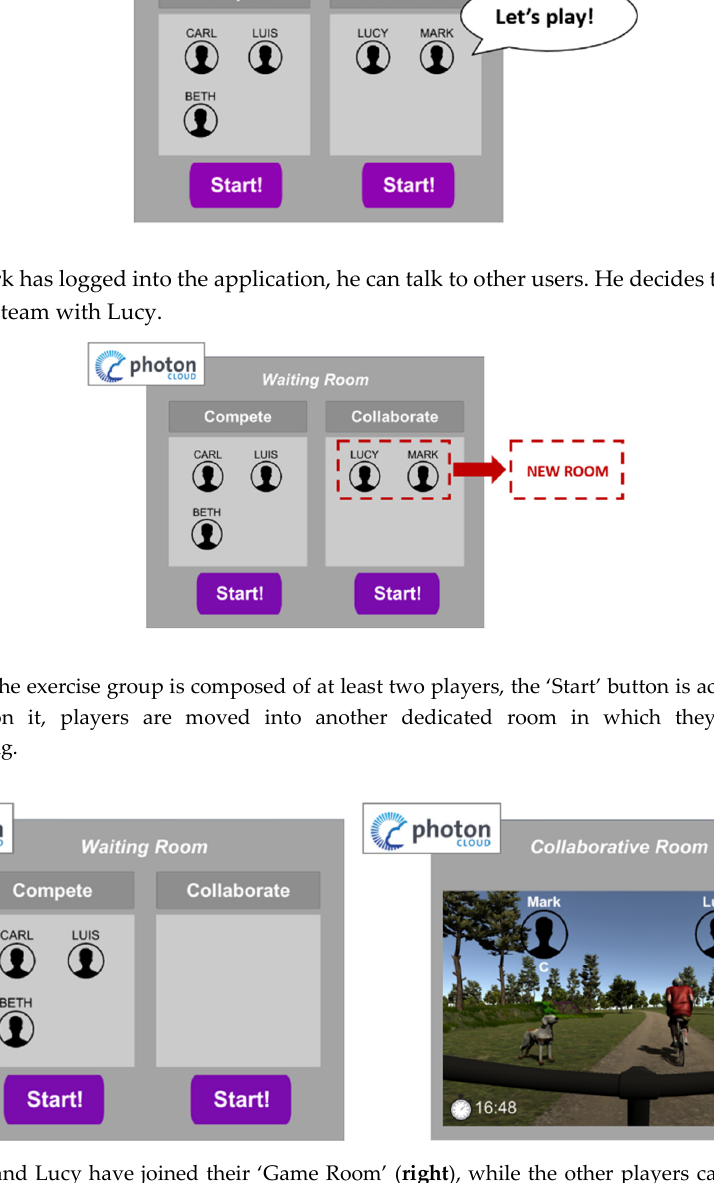
Figure 4. An exemplificative representation of the application flow.